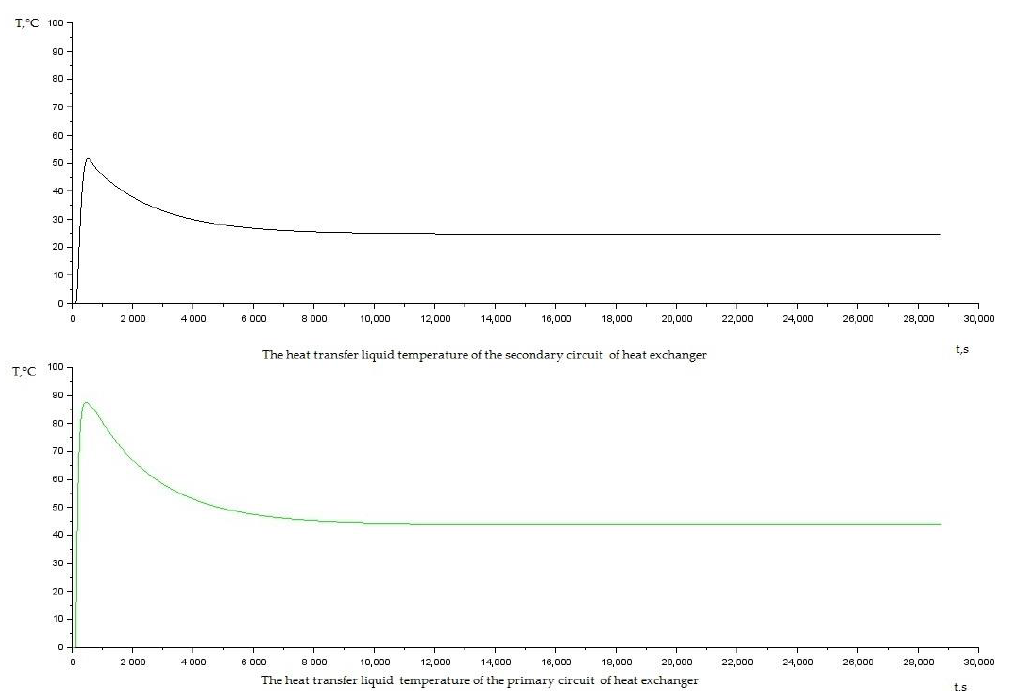
Figure 7. Transient characteristics of the model of the automatic control system of the temperature of the heat carrier without an acoustic–magnetic device.